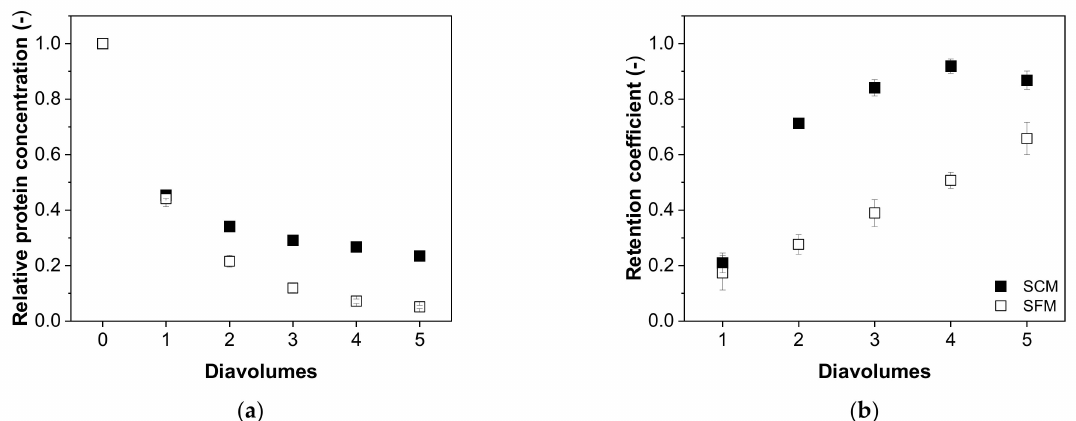
Figure 8. The correlation between the number of diavolumes and ( a ) the relative concentration of total protein and ( b ) the retention coefficients for total protein during the purification of MV by UF/DF. Data are means ± SEM (n = 5)